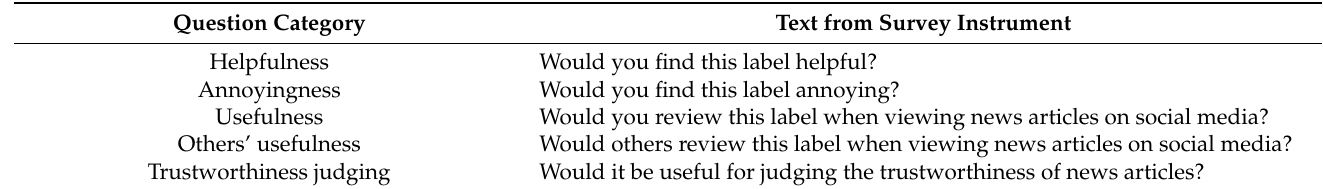
Table 1. Survey instrument questions for each label instrument. Respondents were presented with each proposed label instrument and were asked the following